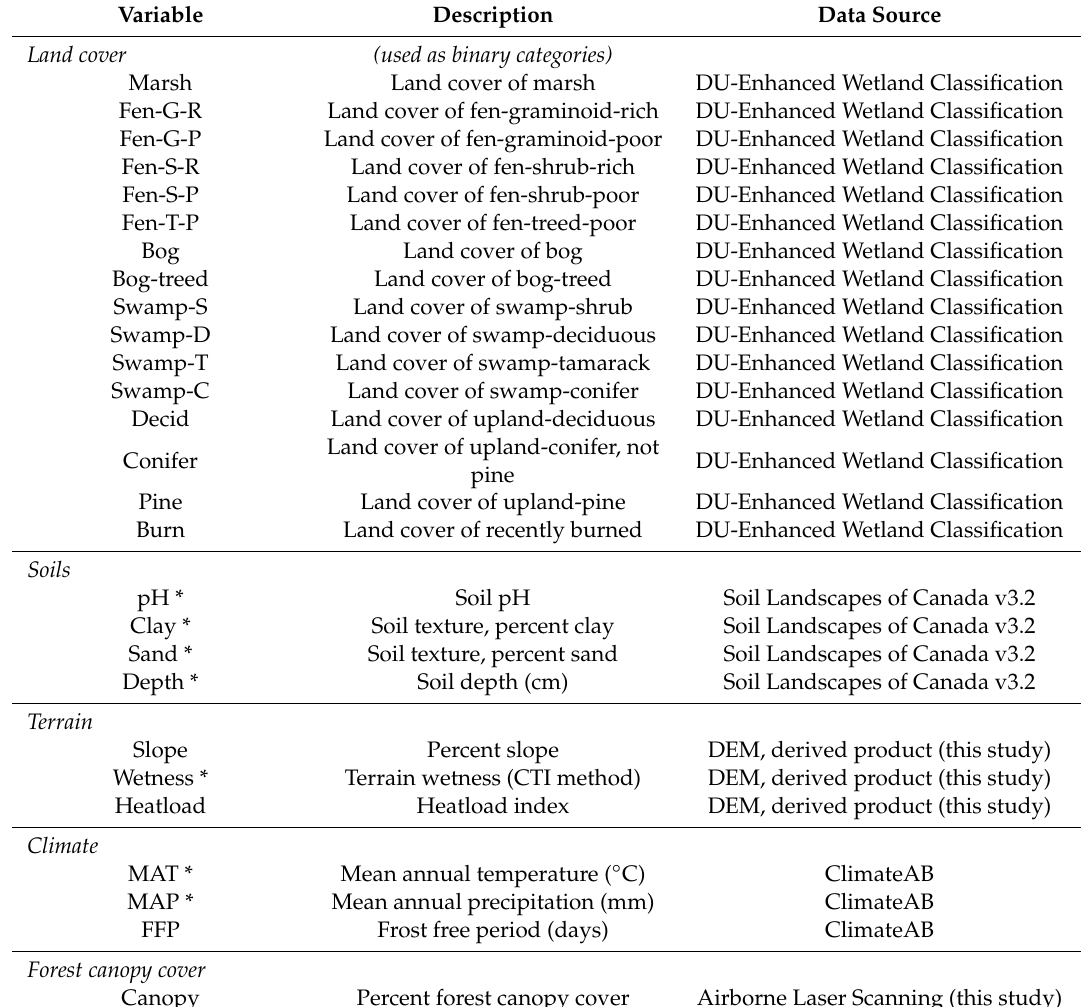
Table A1. List of environmental variables used for modeling blueberry shrub distribution, abundance, and fruit production. Note that the forest canopy cover variable was only used for modeling fruit production and that some variables were tested for non-linear responses using quadratic models as indicated by *. DU-Enhanced Wetland Classification of land cover types were provided at a resolution of 30 m and rescaled to 50 m using a majority filter. Soil Landscapes of Canada was polygon-based and thus converted to a raster at a 50 m resolution. Terrain variables were derived from a 50 m DEM, while ClimateAB variables were re-scaled to 50 m from a 300 m model using bilinear interpolation. Airborne Laser Scanning data were processed for this study at a 50 m